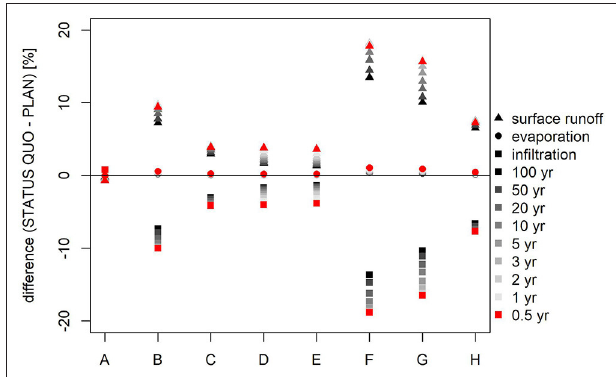
FIGURE 3 | Differences in water fluxes (surface runoff, evaporation, and infiltration) between the STATUS QUO and the PLAN models of the eight low-density housing developments (A–H) for rain events of increasing annuality (0.5–100 years; Supplementary Figure 1 ). A negative difference of water fluxes corresponds to a decrease in water fluxes in the STATUS QUO compared to the PLAN; whereas, accordingly, a positive difference corresponds to an